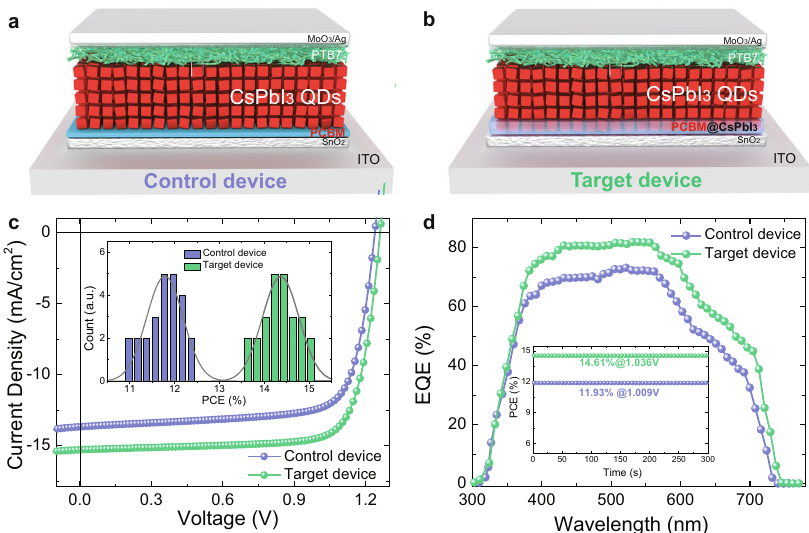
Fig. 2 Photovoltaic performance of solar cells. a , b Schematic diagram of the control device and target device. c J – V curves measured under AM 1.5 G solar irradiation at 100 mW/cm 2 (inset: PCE distribution of control and target devices). d EQE curves of control and target devices (inset: stabilized power output of control and target devices).